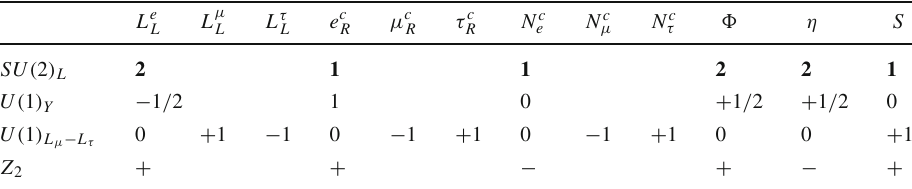
Table 1 The particle content and the charge assignment under SU ( 2 ) L × U ( 1 ) Y ×